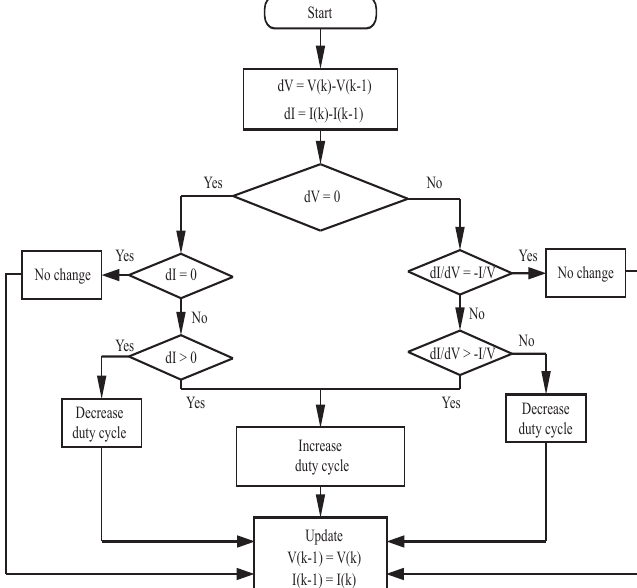
Figure 3. Flow chart of INC algorithm.